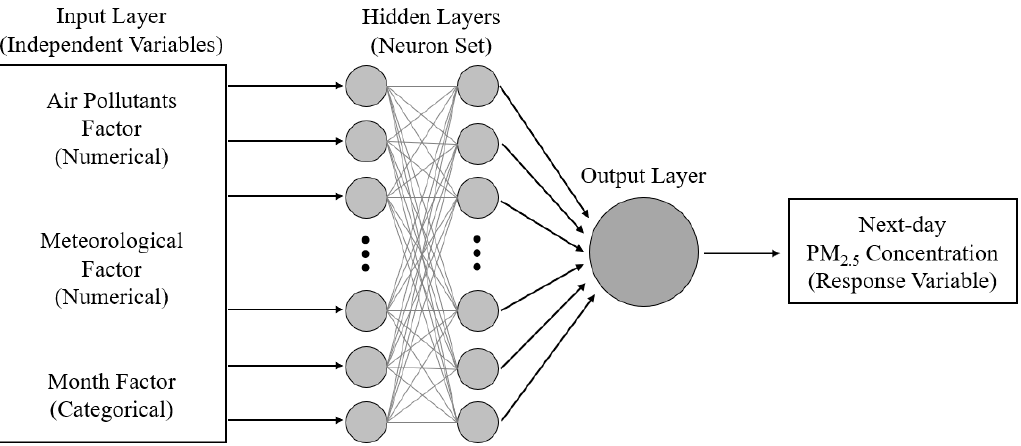
Figure 1. Scheme of the artificial neural network model.